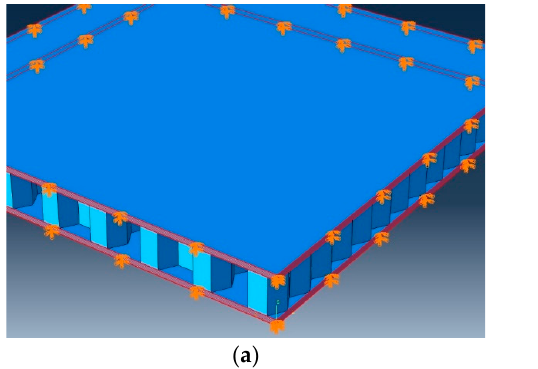
Figure 6. ( a ) Boundary conditions ( b ) core and top plate tie constraint.